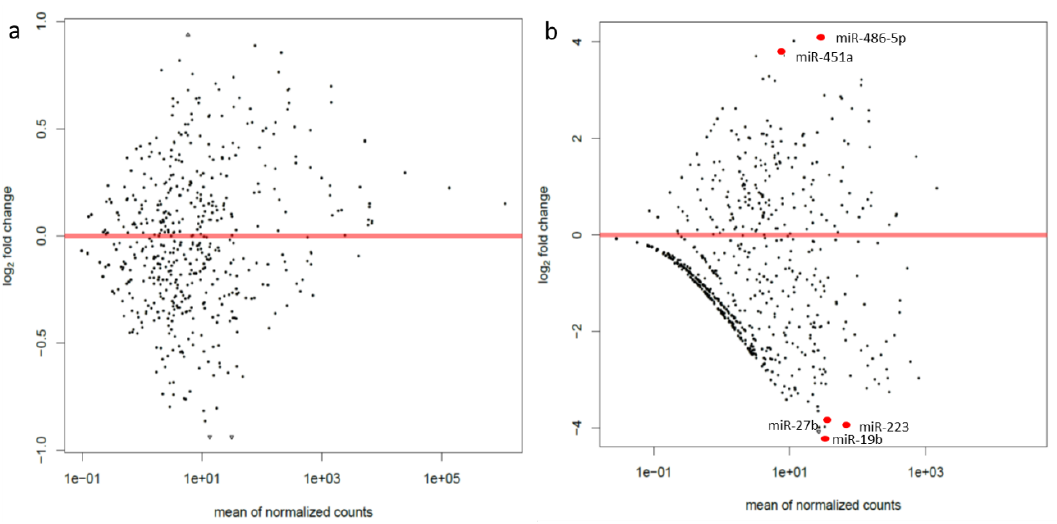
Figure 1. MA-plot between exacerbation and stable period of the gene expression counts ( a ) for the whole blood and ( b ) for sputum. Significantly altered miRNAs are marked as red dots (DeSeq).